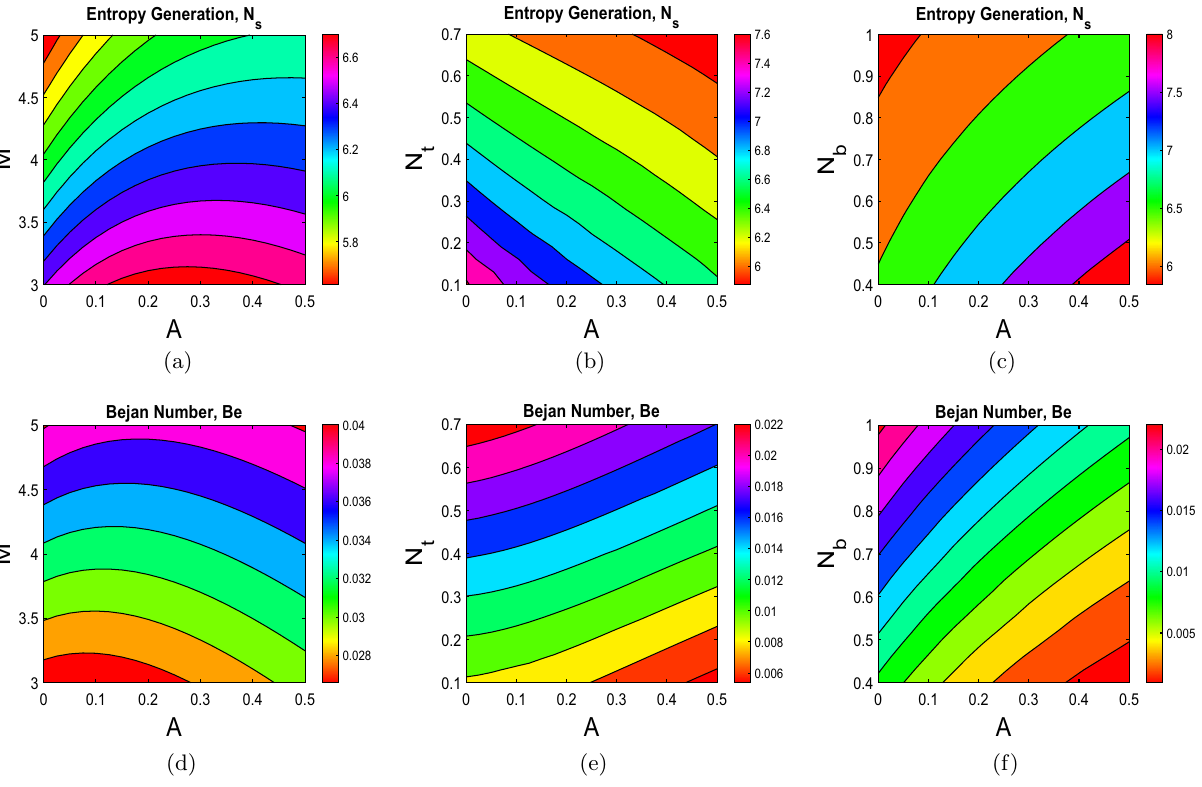
Figure 4. ( a ) N s versus M, ( b ) N s versus N t , ( c ) N s versus N b , ( d ) Be versus M, ( e ) Be versus N t , and ( f ) Be versus N